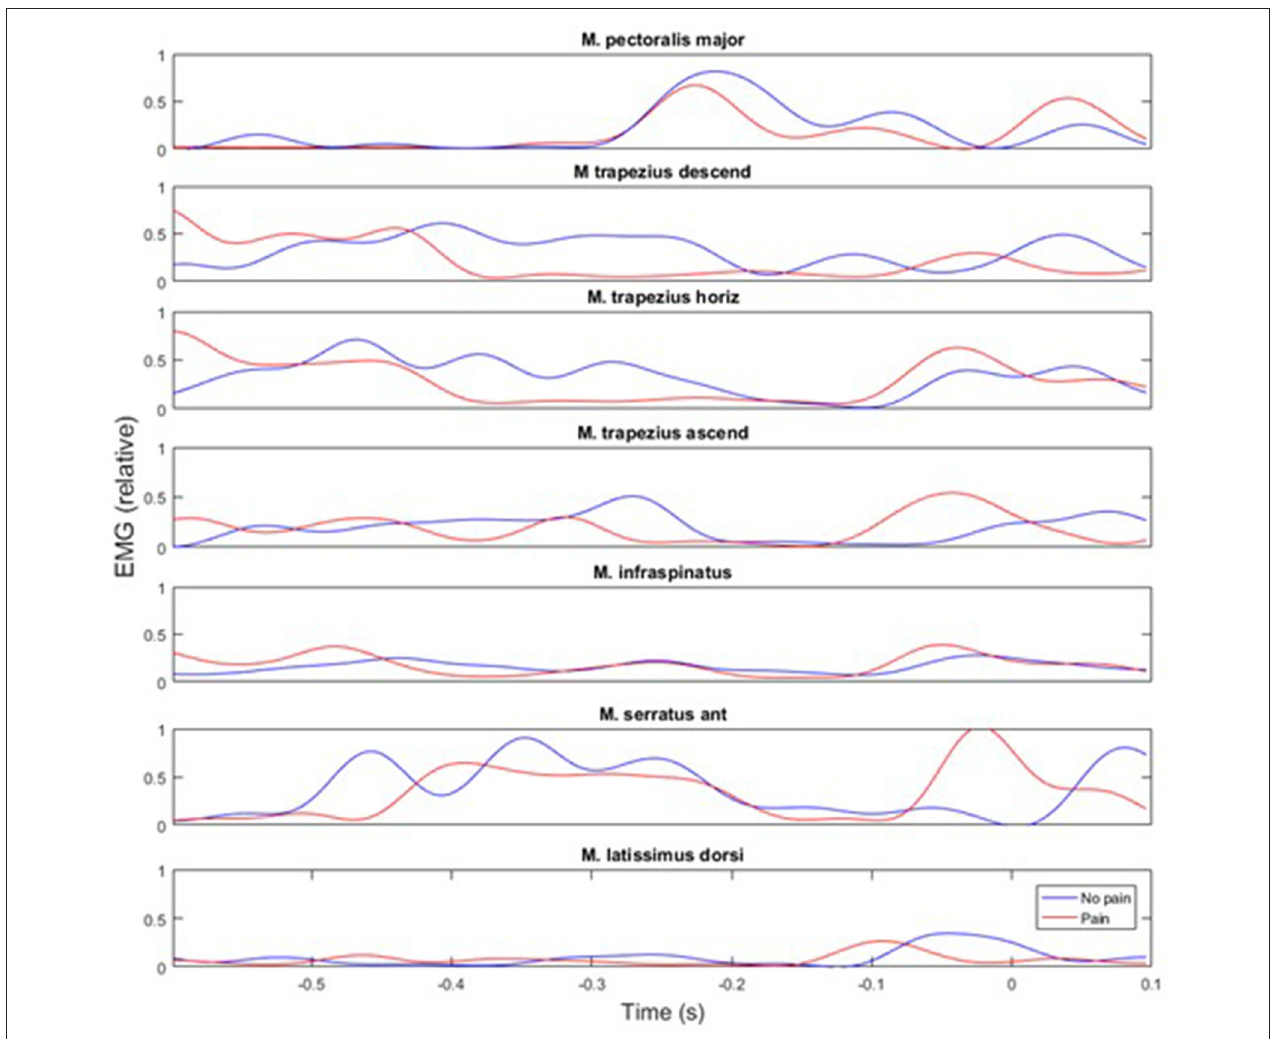
FIGURE 7 | Representative example of muscle activity during a throw performed by an athlete with shoulder pain (red line) and no pain (blue line). Point 0 is defined as ball release.